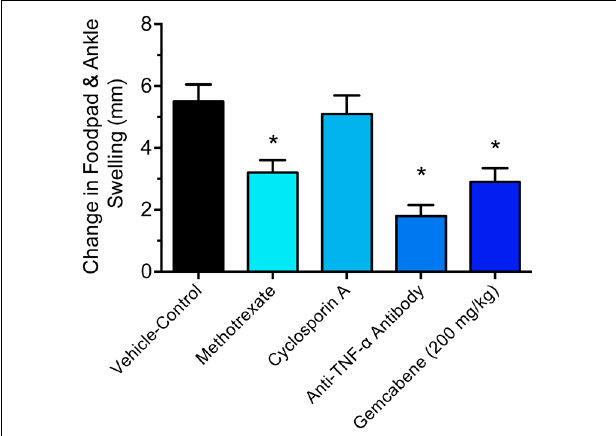
FIGURE 2 | Efficacy of reference agents in the collagen antibody-induced joint swelling and arthritis mouse model. Methotrexate (4 mg/kg), cyclosporine A, and anti-TNF- α antibody (83.33 µ g) were evaluated in this study. BALB/c mice ( n = 5) were administered by oral gavage (methotrexate and cyclosporine) or intraperitoneal injection (anti-TNF- α antibody). The details are provided in the “Materials and Methods” section. The results of day 9 treatment are only shown. Data presented show changes in the footpad and ankle swelling and are expressed as mean ± SEM. ∗ Significantly different compared to vehicle